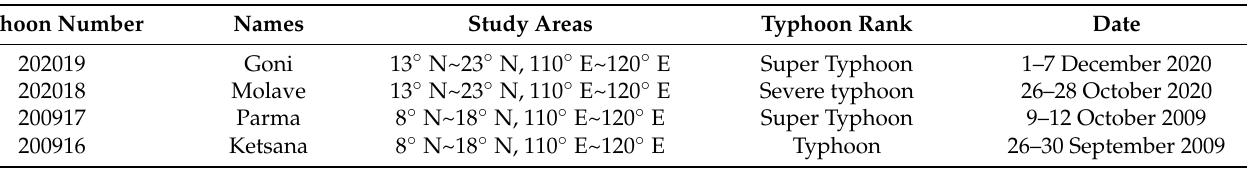
Table 3. Basic information of successive typhoons.